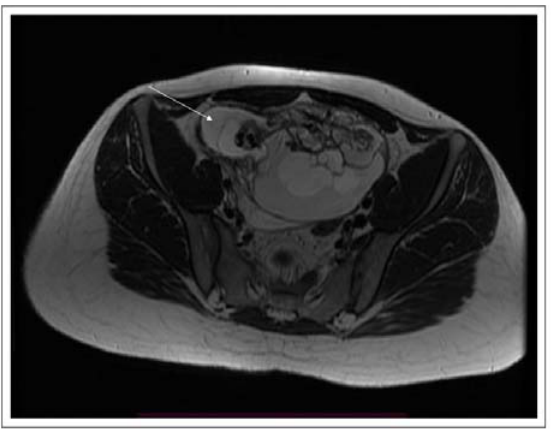
Figure 1. NMR of the pelvis minor in the transverse plane. The arrow indicates the tumor in the right ovary.